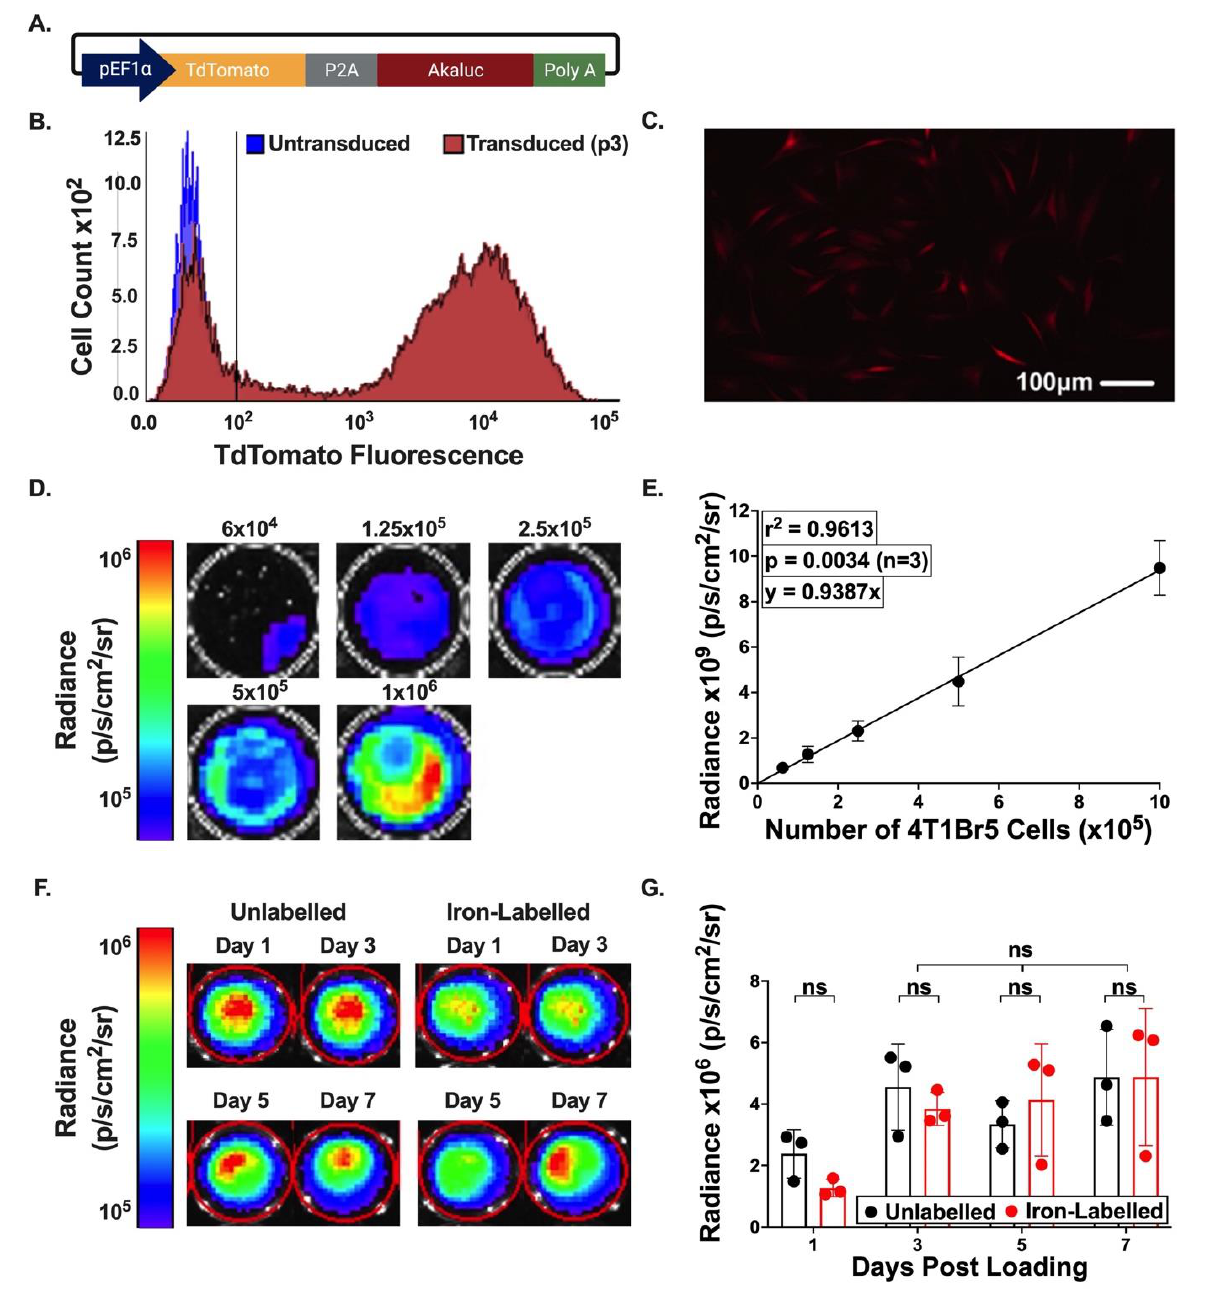
Figure 1. Transduction and characterization of 4T1Br5 cells. ( A ) Vector map consisting of pEF1α promoter, tdT and Akaluc. ( B ) Flow cytometry of untransduced (blue) and transduced (red) cell populations at passage 3. Cell count vs. tdT fluorescence intensity was plotted in a histogram. ( C ). Fluorescence microscopy further confirmed tdT expression. ( D , E ) Total BLI signal vs. cell numbers ranging from 6 × 10 4 –1 × 10 6 cells. BLI signal scale shown in radiance (p/s/cm 2 /sr). ( F , G ) Total BLI signal for unlabelled (Black) and Synomag-D-labelled (Red) cells, up to 1 week post loading. ns: no